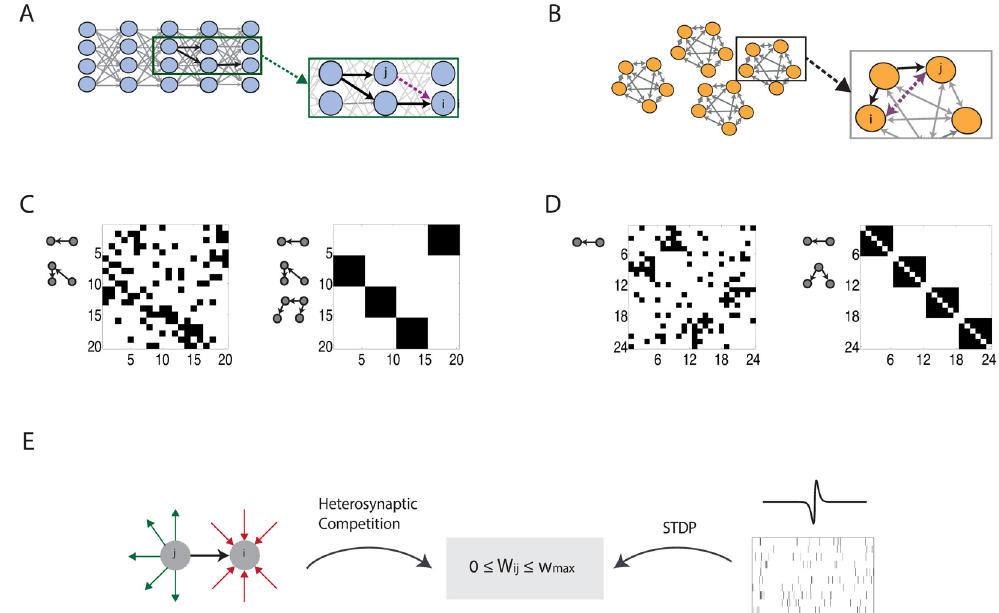
Fig 4. Self organization into global structures. A. The third order motif {2, 1} promotes formation of wide synfire chain connectivity, by encouraging neurons that receive input from the same pre synaptic neuron to project to the same post synaptic neuron. B. The second order motif {1, 1}, combined with a symmetric STDP function, promotes formation of self connected assemblies by encouraging two neurons that receive inputs from a common source to increase their synaptic coupling reciprocally. C-D. Steady state connectivity, obtained from simulations in which the motif coefficients f α , β are tuned artificially. STDP is combined with heterosynaptic competition. Neurons are ordered such that the matrix represents the optimal feed forward connectivity (C) or self connected assemblies connectivity (D). C. Left — results from dynamics that contain only the motifs {1, 0}, {0, 1}, {2, 0}, {0, 2}. The simulation does not converge into synfire chains connectivity. Right — the simulation contains also the motifs {2, 1}, {1, 2}. The simulation converges into synfire chain connectivity. D. Left — the dynamics contain only the motifs {1, 0}, {0, 1}. The simulation does not converge to assemblies. Right — the dynamics include also the motif {1, 1}. The connectivity converges into self connected assemblies. E. The drift in the excitatory connections is driven by three plasticity mechanisms: (i) Spike timing dependent plasticity. (ii) Heterosynaptic competition between all synapses that terminate in the same post synaptic neuron (red arrows), and all synapses that originate from the same pre synaptic neuron (green arrows). (iii) A hard bound on the synaptic